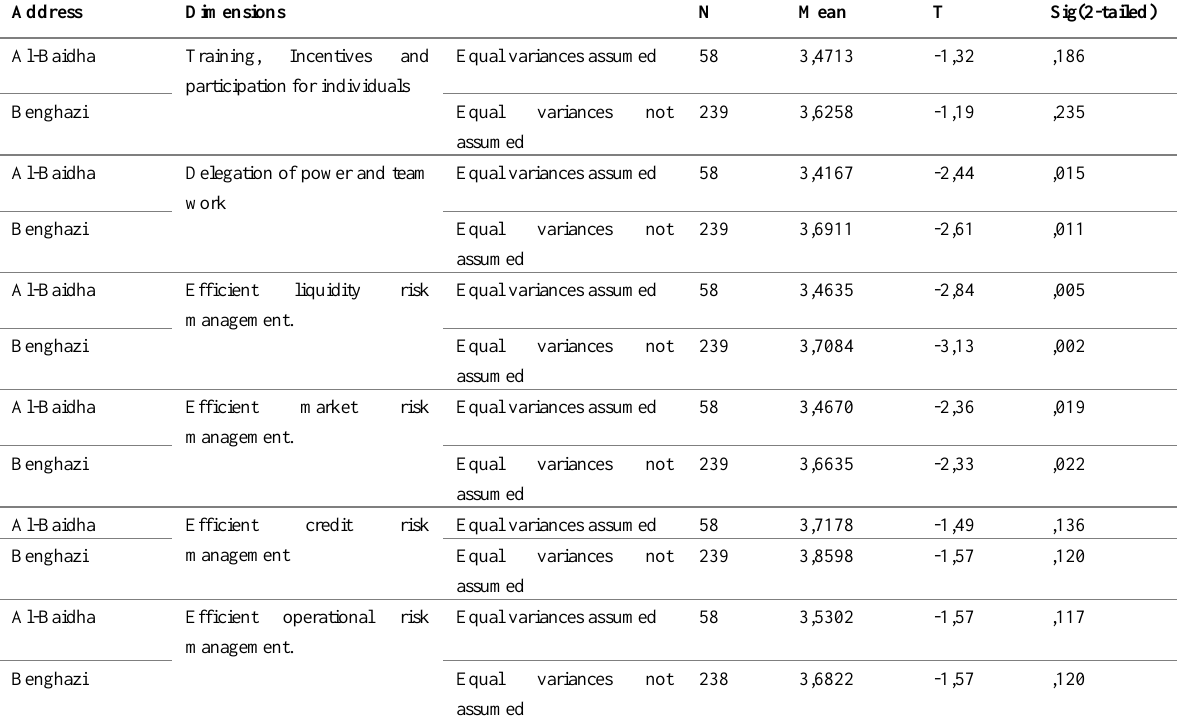
Table 9: Independent Sample test for two